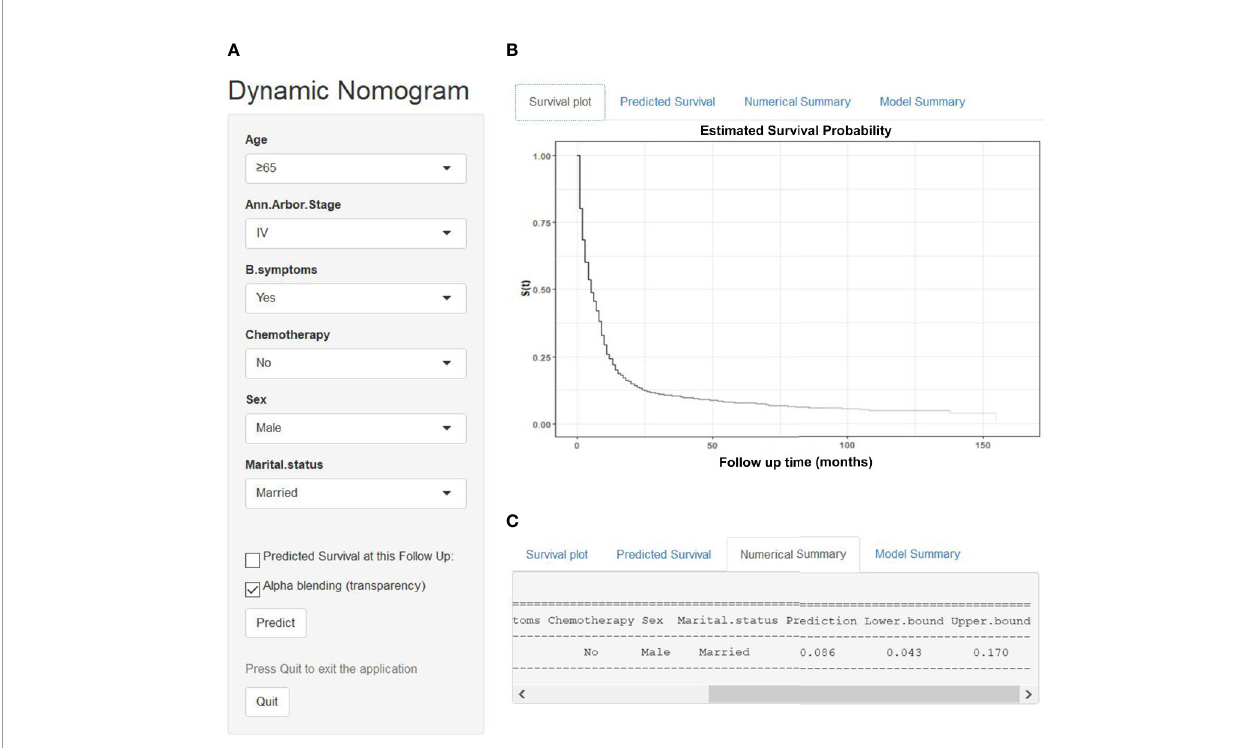
FIGURE 6 | An example to illustrate the usage of the web-based survival rate calculator. (A) A 66-year-old married man was diagnosed as DLBCL with Ann Arbor stage of IV, presented with B symptoms, refused chemotherapy, (C) his 5-year cancer-speci fi c survival rate is approximately 8.6% (95% CI 4.3 – 17.0%). (B) His survival plot according to the web survival rate